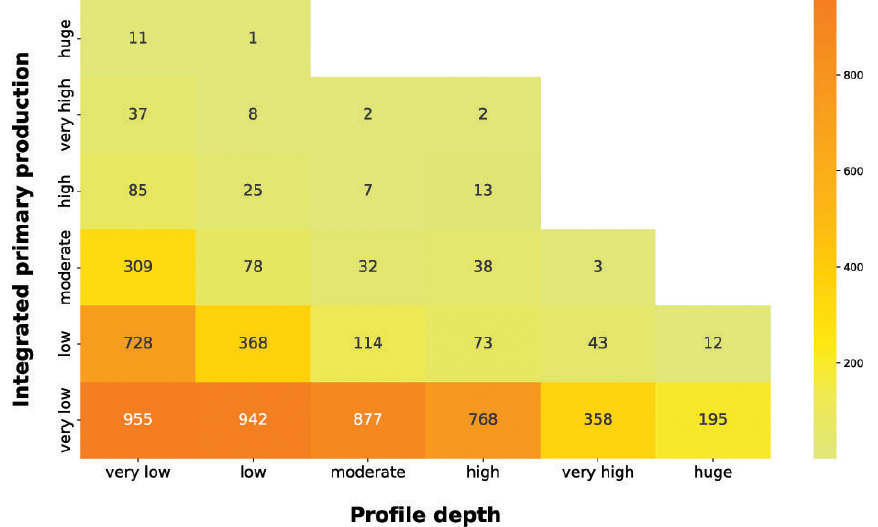
Figure 11. IPP vs. profile depth. The yellow-to-orange heatmap highlights the relationship between the depth-integrated phytoplankton production and the production profile